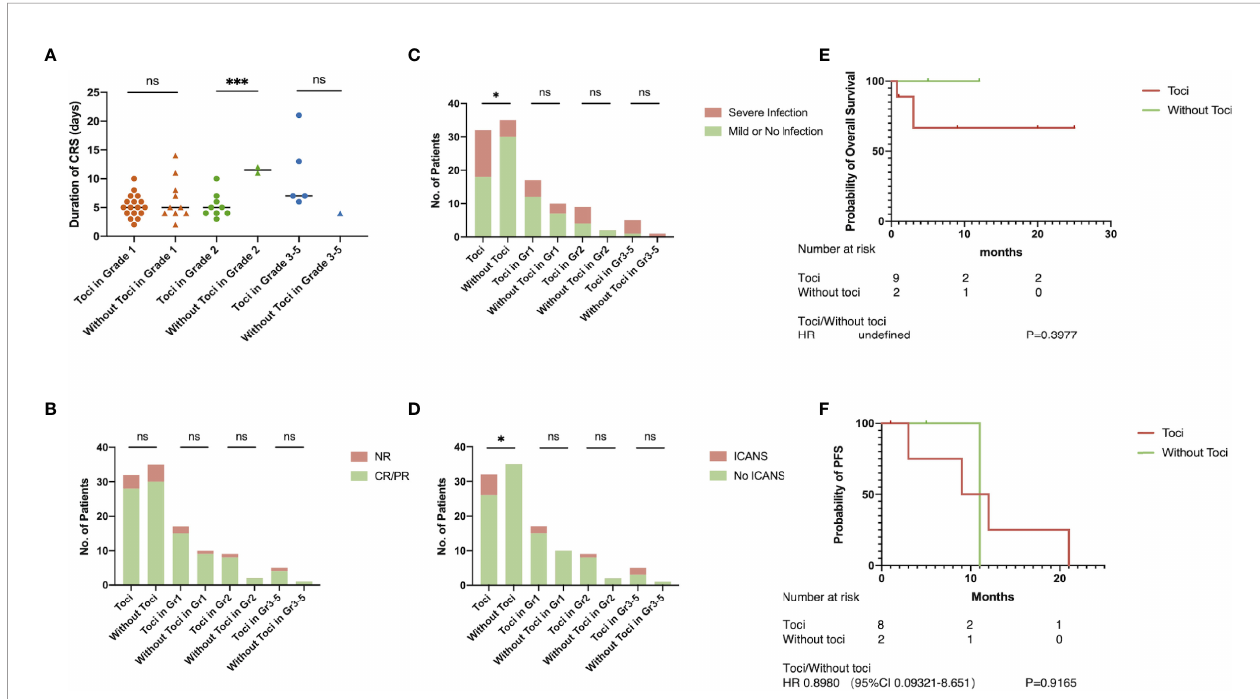
FIGURE 1 | Tocilizumab shortened the duration of CRS. The grading of CRS and whether to use Tocilizumab were the basis for grouping. (A) Duration of CRS; (B) objective response rate; (C) incidence of severe infection; (D) incidence of ICANS; (E) overall survival rate in patients with grade 2 CRS; (F) progression-free survival in patients with grade 2 CRS. *p < 0.05; ***p <